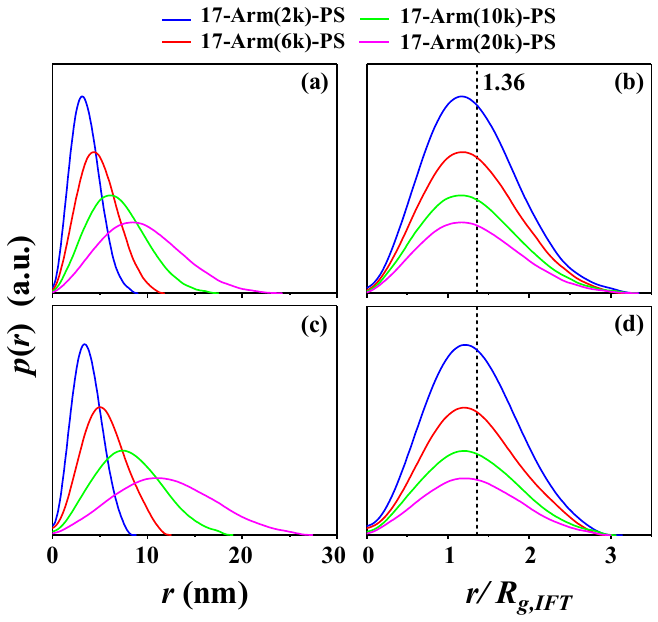
Figure 6. Indirect Fourier transformation (IFT) analysis results of the X-ray scattering data in Figure 2 ( a , b ) CHX at 35.0 ° C ( Θ condition); ( c , d ) THF at 25.0 ° C (good solvent). p ( r ) is the pair distance distribution function.